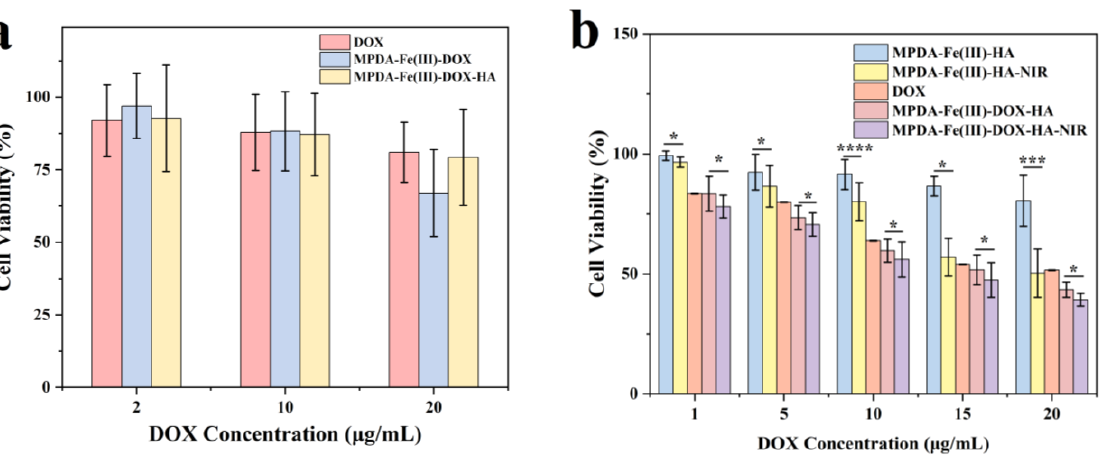
Figure 9. Cytotoxicity analysis using the MTT method (toxicity of different concentrations of drug delivery system on L929 cells ( a ), toxicity of different concentrations of drug delivery system to HCT-116 cells under different NIR ( b )) (* p < 0.05; *** p < 0.001; **** p < 0.0001).